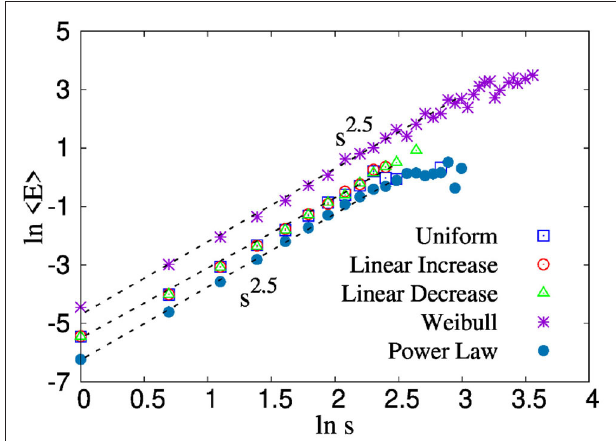
FIGURE 7 | The figure shows the variation of average energy h E i with avalanche size s for LLS fiber bundle model. We have produced the study for five different threshold distributions. We observe for all distributions, h E i ∼ s γ , where γ has a value 2.5 independent of the nature of the distribution.